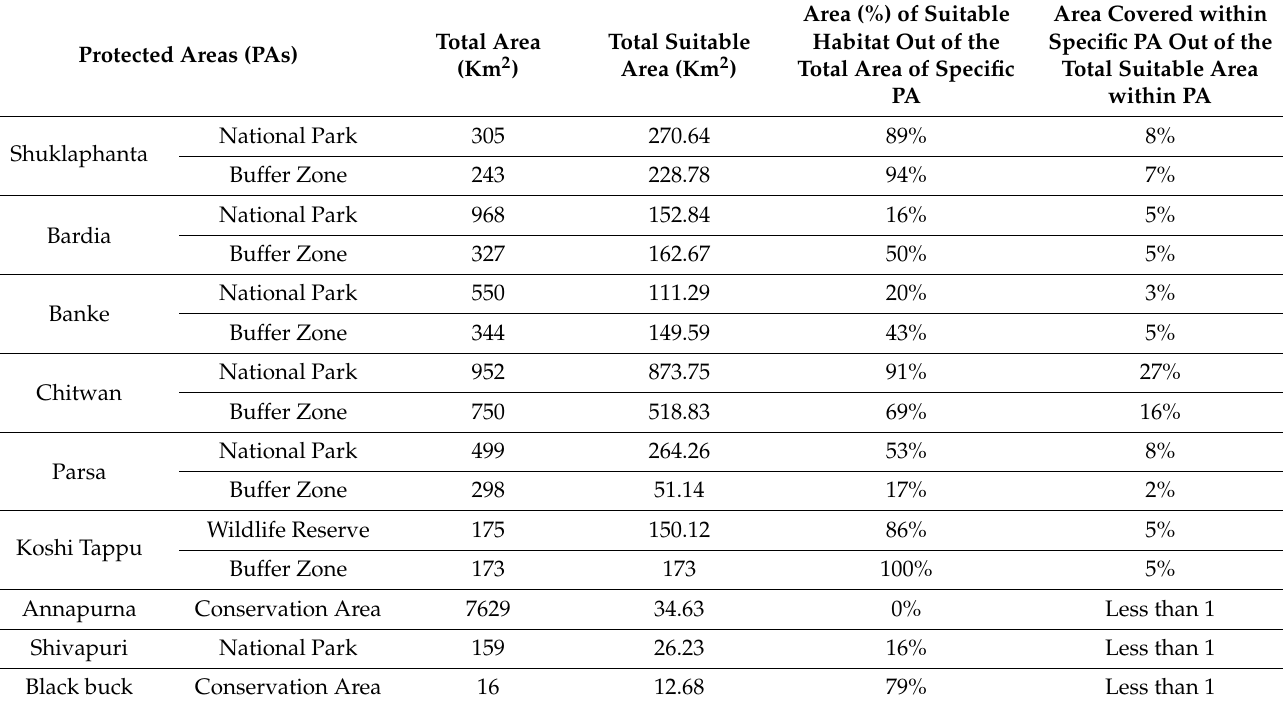
Table 2. The significant protected areas and areas of predicted suitable habitats for the Blue bull in